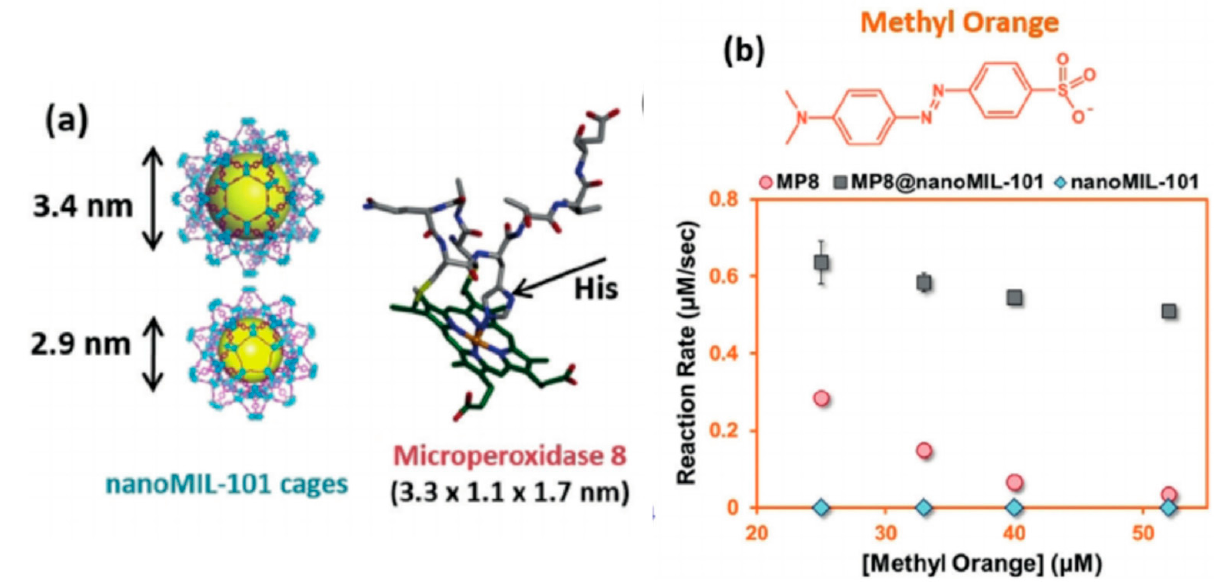
Figure 5. Methyl orange (MO) dye degradation of by microperoxidase (MP)-8@nanoMIL-101: ( a ) NanoMIL-101 and the structure of microperoxidase-8, and ( b ) the degradation rate of MO by MP-8@nanoMIL-101 Reprinted from [130] with permission from John Wiley and Sons. Copyright © 2021 WILEY-VCH Verlag GmbH and Co. KGaA, Weinheim. License Number: